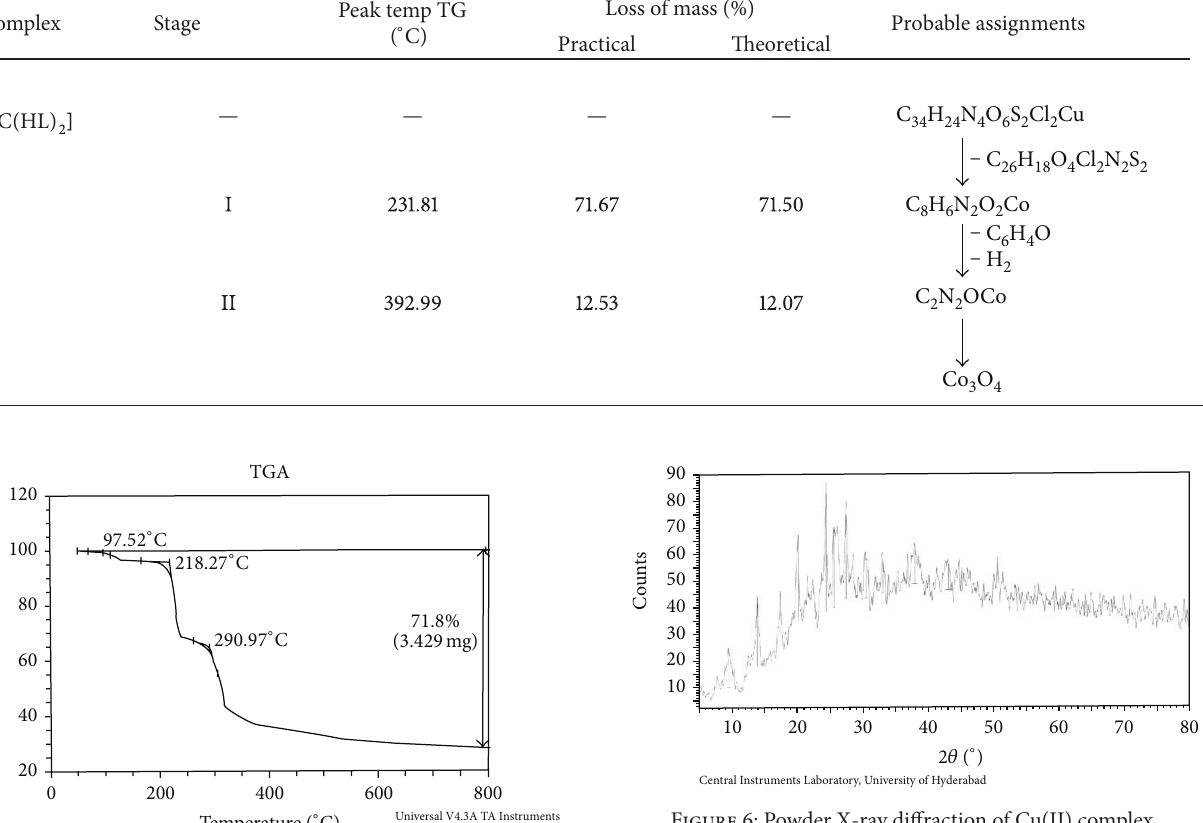
Figure 6: Powder X-ray diffraction of Cu(II) complex.